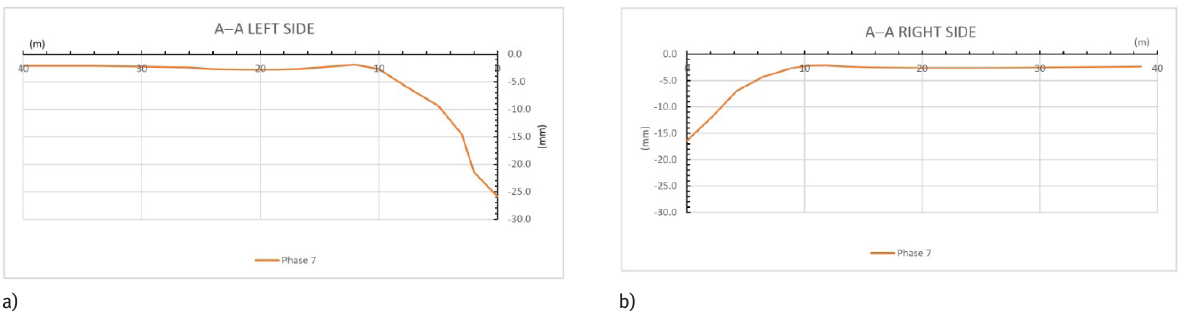
Figure 10: Phase 7 of the implementation – disassembly of straining beams, followed by the construction of walls and columns in the underground part; graph of vertical displacements of the land surface in the A–A cross section: a) on the left, b) on the